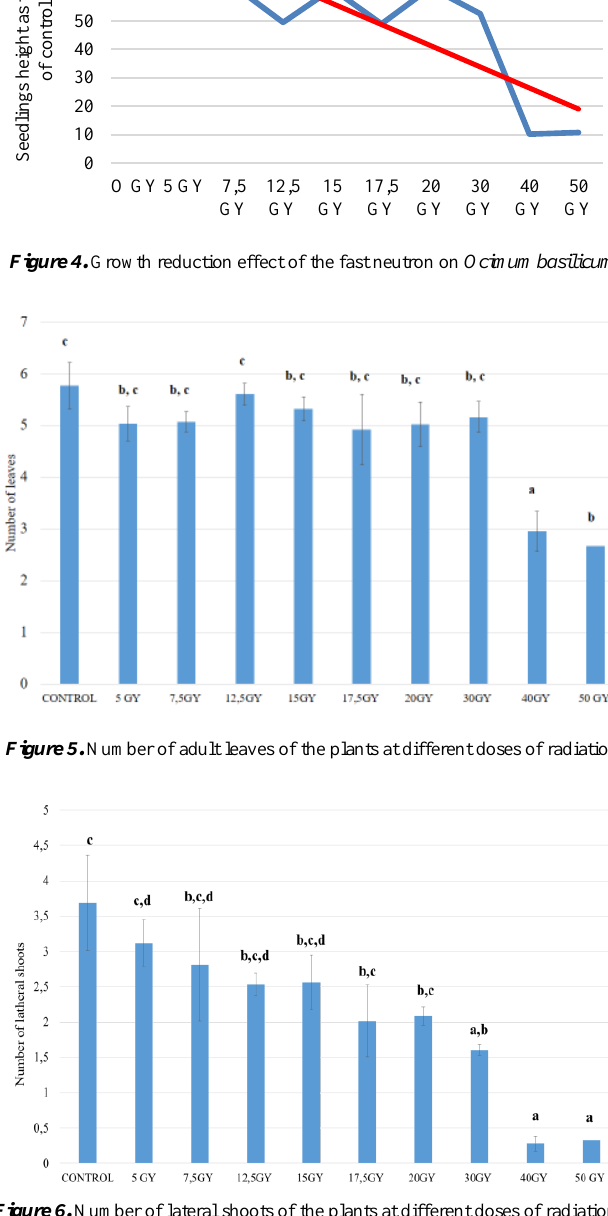
y = -7.4422x + 93.364 R² =